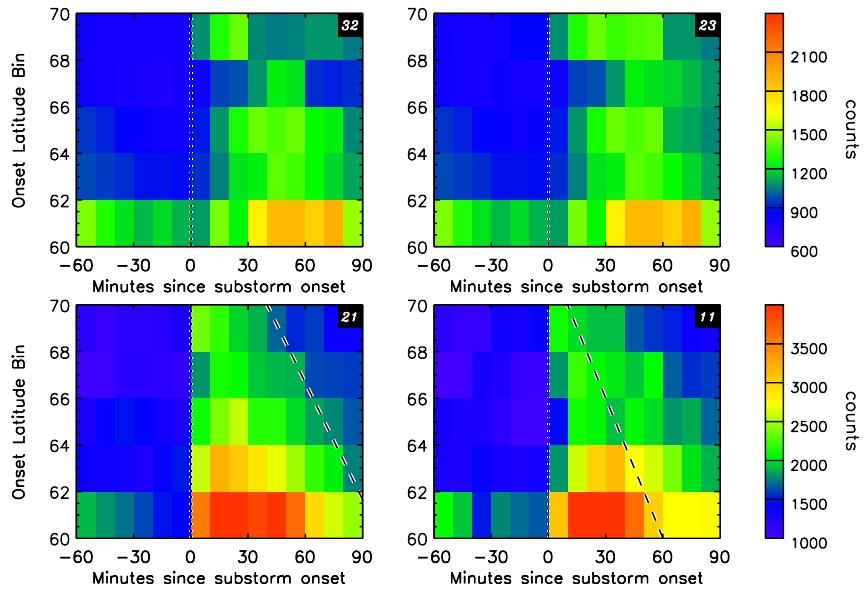
Fig. 6. 10-min averages of WIC auroral electron counts, plotted for the same locations as the flow data in Fig. 5 as a function of time relative to substorm onset, for five onset-latitude bins. The dotted and dashed lines are as in Fig. 5 (after Milan et al.,